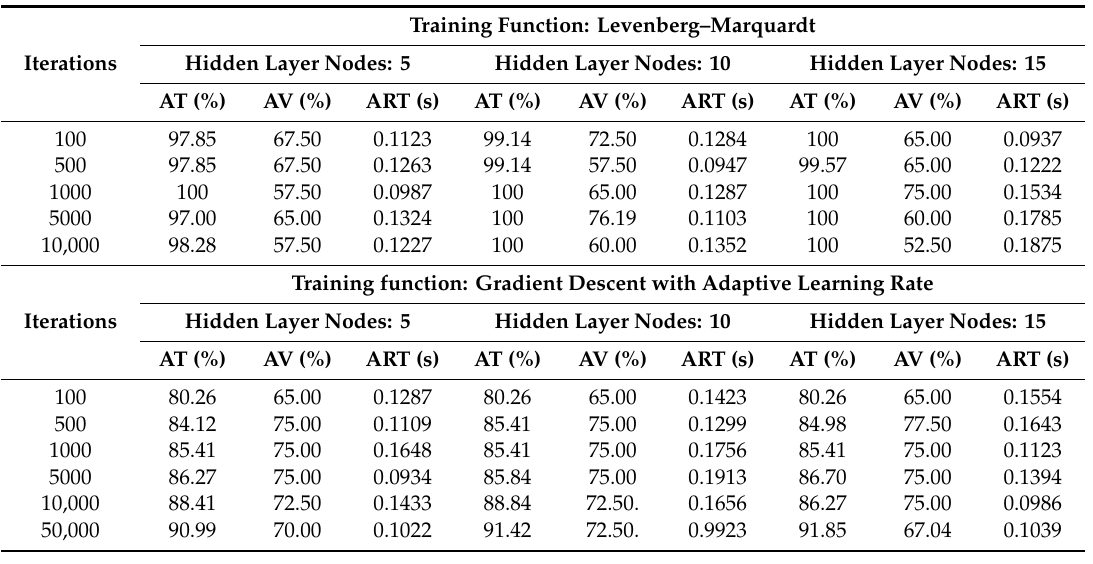
Table 3. The parameter settings and performance of the artificial neural network